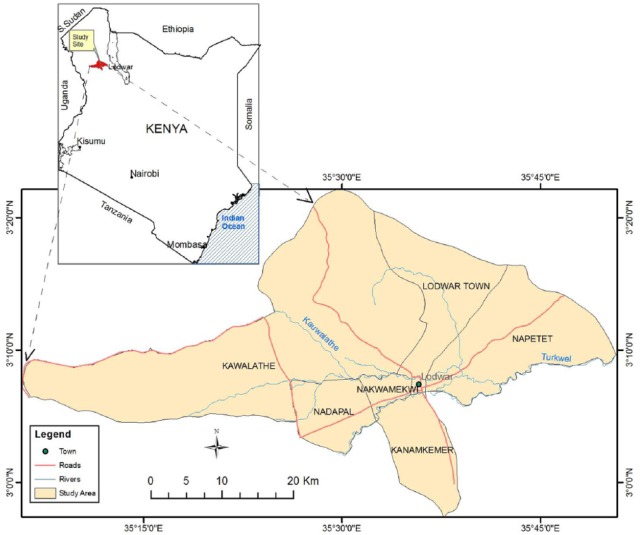
Map of the study area.Source: Topographic map of Kenya; scale 1:100 000—field survey.